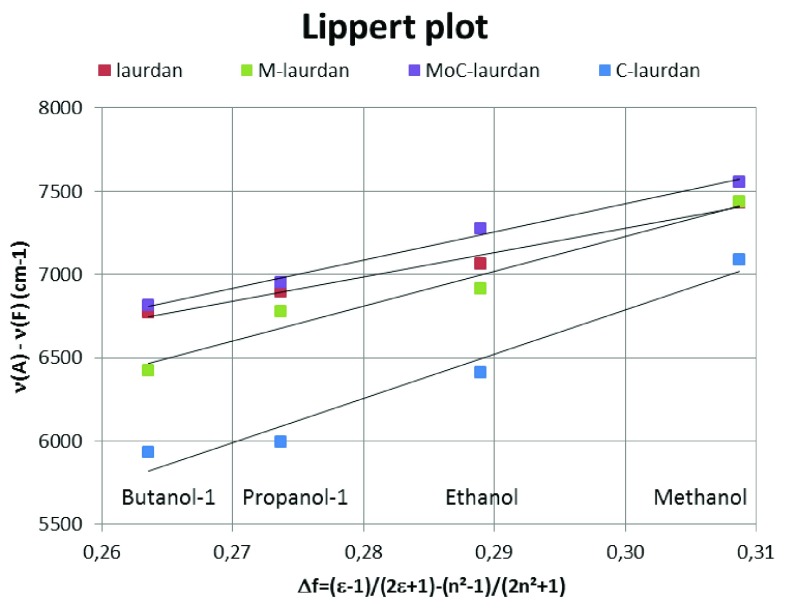
We built the Lippert plots of laurdan, M-laurdan, MoC-laurdan and C-laurdan in alcohols (butanol-1, propanol-1, ethanol and methanol).The Lipper plots shows the Stokes shift (
νA¯–
νF¯) versus the orientation polarizability (Δf) and therefore gives an estimation of the fluorophores solvent sensitivity. The linearity of the laurdan family curves can be interpreted as a general solvent effect in the spectral shift. Besides, the similarity in the slopes obtained for the different curves drives us to conclude that the different dyes are similarly sensitive to solvent polarity.